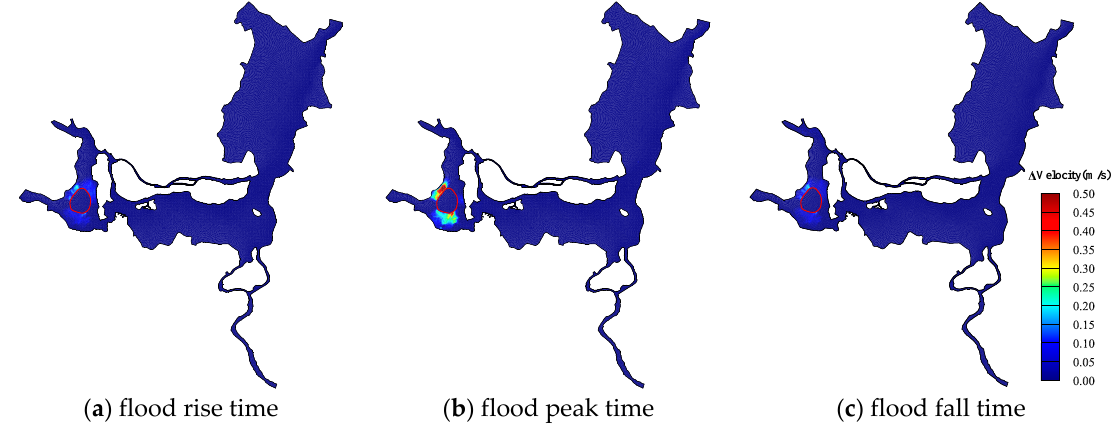
Figure 5. The flow velocity contour without the construction of the central lake reservoir (unit: m/s)